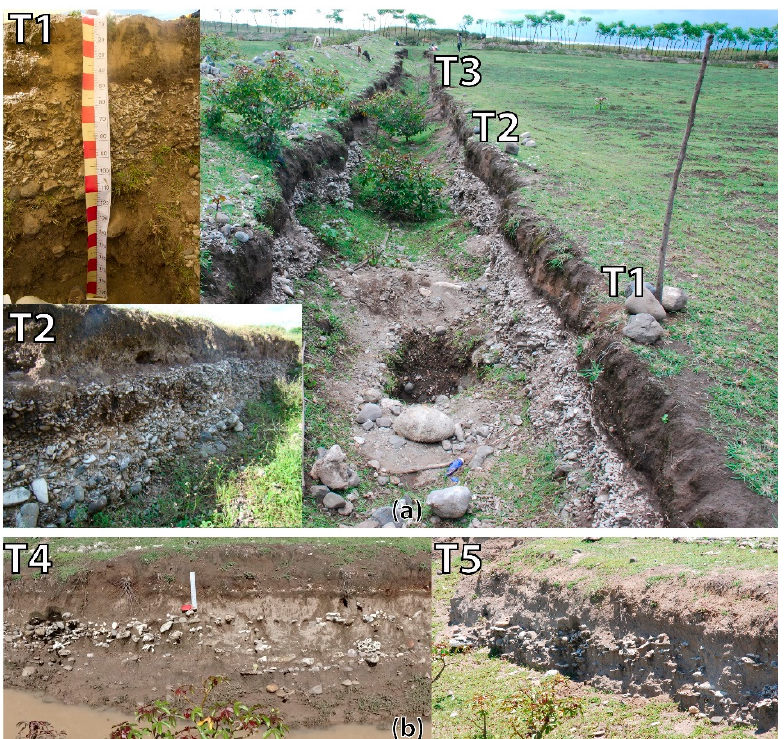
Figure 5. ( a ) The locations of T1, T2, and T3 sampling points (oriented seaward from T1 to T3) in an abandoned fishpond in Kiantar Village with an example of a massive tsunami deposit with a single ~1.5 m thick layer on the sampling point of T1 and T2; ( b ) The locations of T4 and T5 sampling points with three different layers of marine-origins deposits without paleo-sols between each layer.